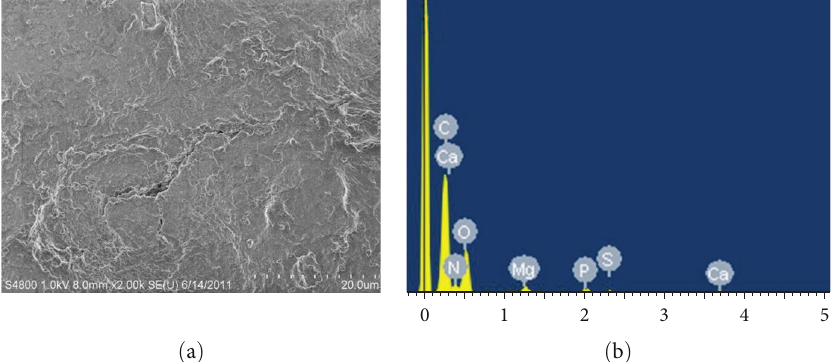
F IGURE 7: (a) The surface of the magnesium alloy plate after 8 weeks of implantation was rough with a layer of grayish-white degradation products; (b) EDS of the corrosion products formed on the surface of magnesium alloy plate.